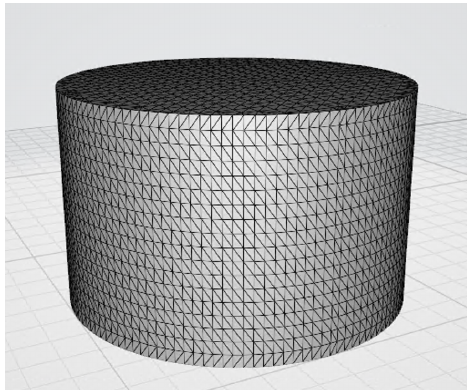
Fig. 3. Discretized surface for the cylindrical buoy with approxi- mately 4,000 panels, used for nonlinear buoyancy and Froude-Krylov pressure calculations in WEC-Sim.